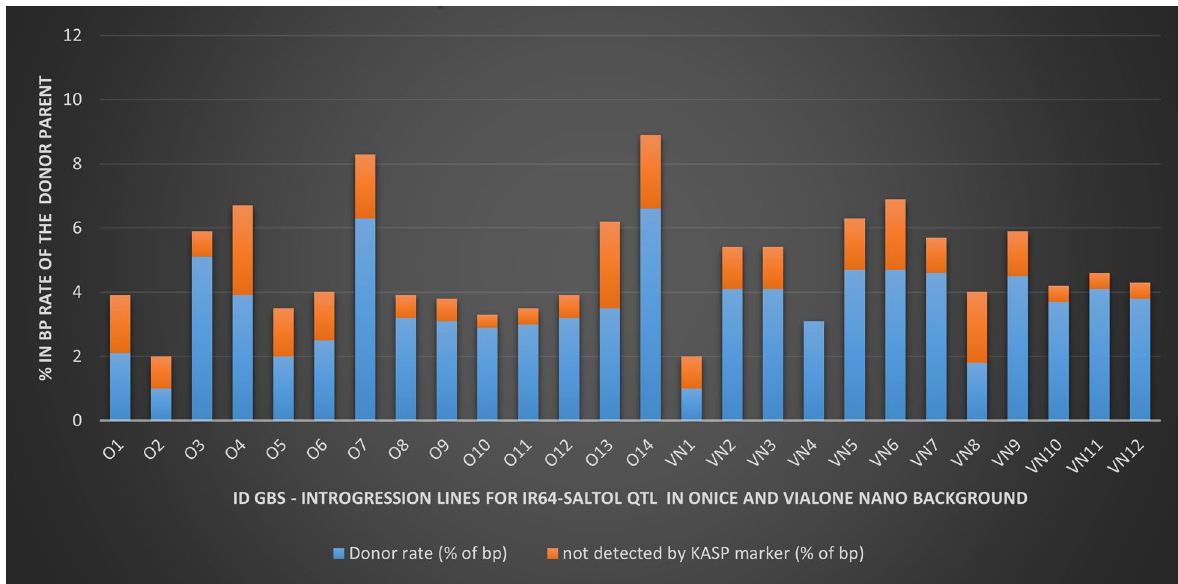
Fig. 4 Comparison of the performances of 96 KASP marker panel and GBS in evaluating the RP genome recovery in the selected BC 3 F 4 introgression lines. The blue bars represent the percentage value in bp of the donor rate based on the KASP markers used in the background selection, while the orange bars represent the percentage value in bp calculated on the GBS data but not detected by KASP